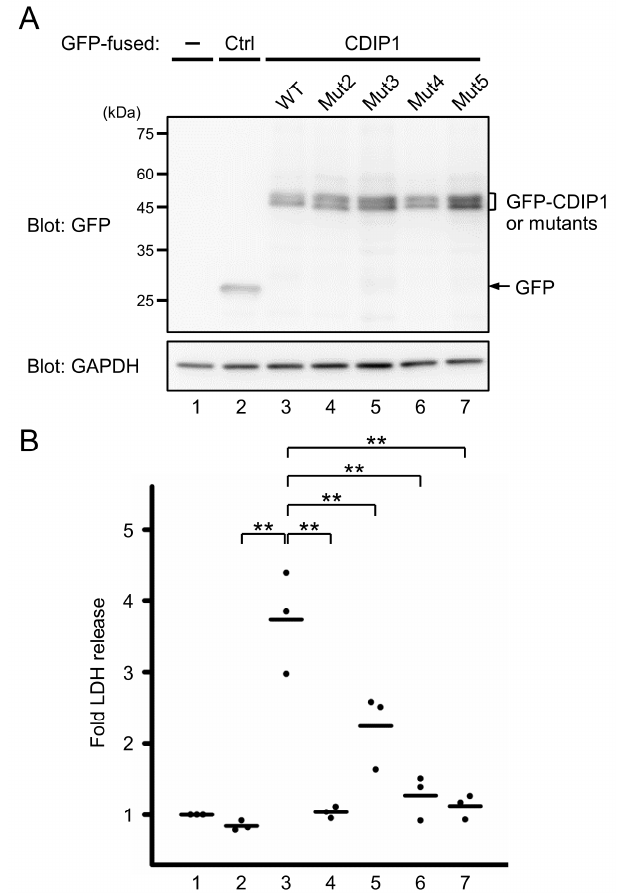
Figure 9. Effects of mutations in the FFAT-like motif on CDIP1-induced cell death. HEK293 cells were transfected with expression plasmids for GFP (Ctrl), GFP-CDIP1 (WT) or GFP-CDIP1 mutants (Mut2–5). Mock-transfected cells were used as a reference to calculate the relative release of lactate dehydrogenase (LDH). ( A ) Representative results of WB analysis of levels of GFP and GFP-fused proteins in cells at 24 h after transfection. GAPDH was detected as a loading control. ( B ) Cell death was monitored by measuring the amounts of LDH released into the medium. Values are expressed as fold LDH release into the medium compared with that of mock-transfected cells. Three independent repetitive experiments were performed and data are expressed as dot plots with means (bar). Statistical significance by one-way ANOVA followed by Tukey’s test is indicated by asterisks (** p < 0.01).